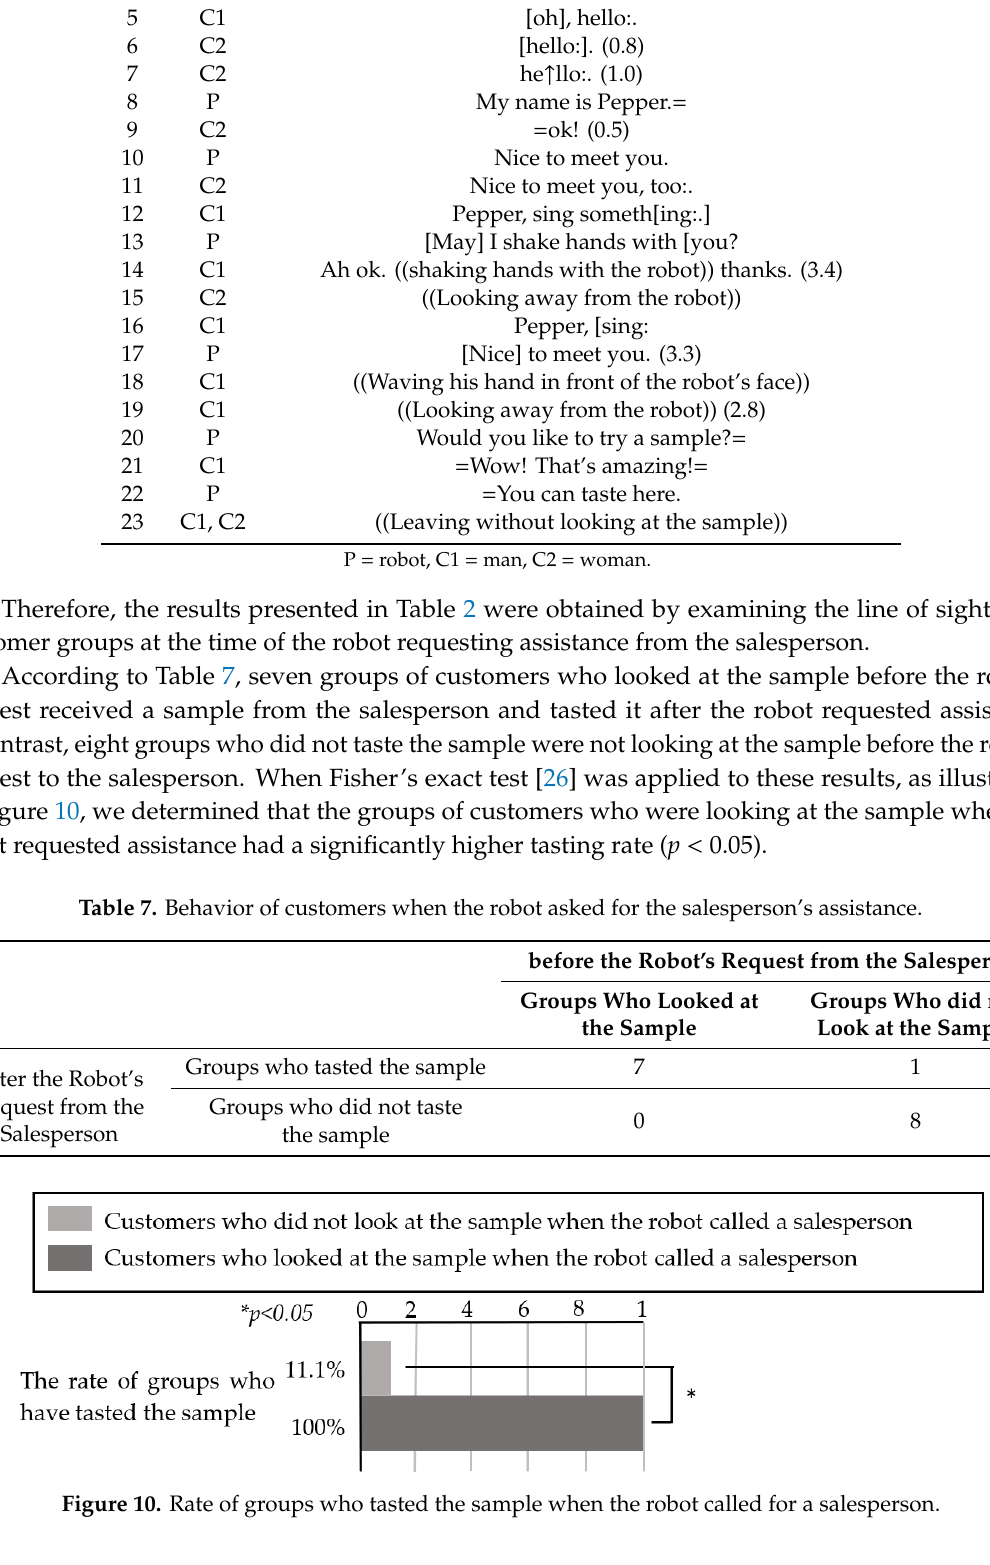
Figure 11. Rate of groups who looked at the sample after the robot suggested a tasting.